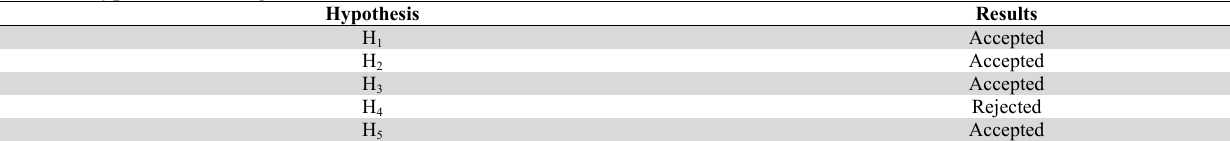
Results of hypothesis testing